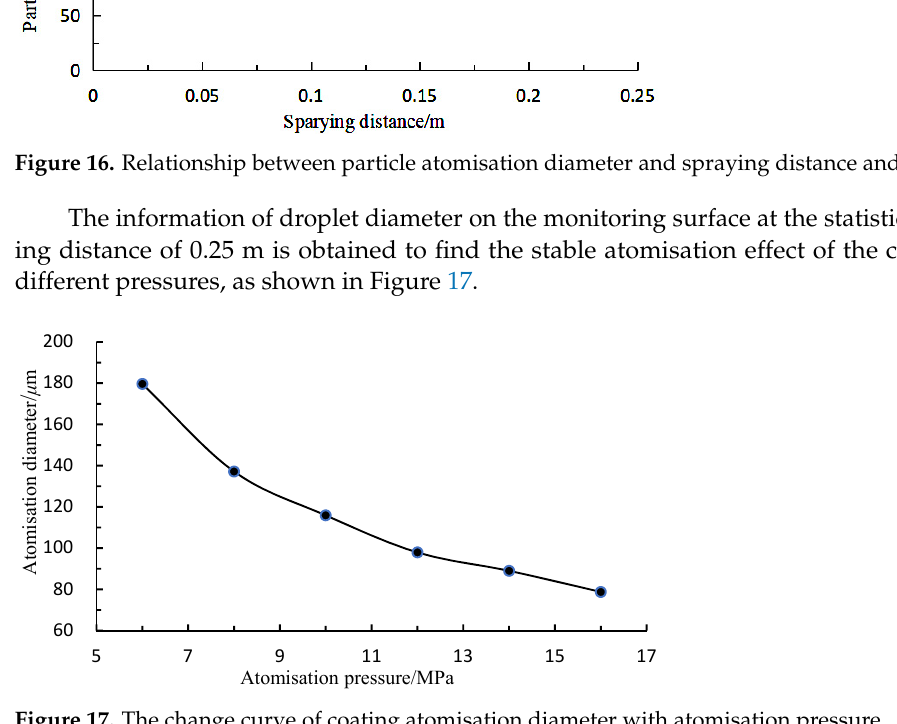
Figure 17. The change curve of coating atomisation diameter with atomisation pressure.